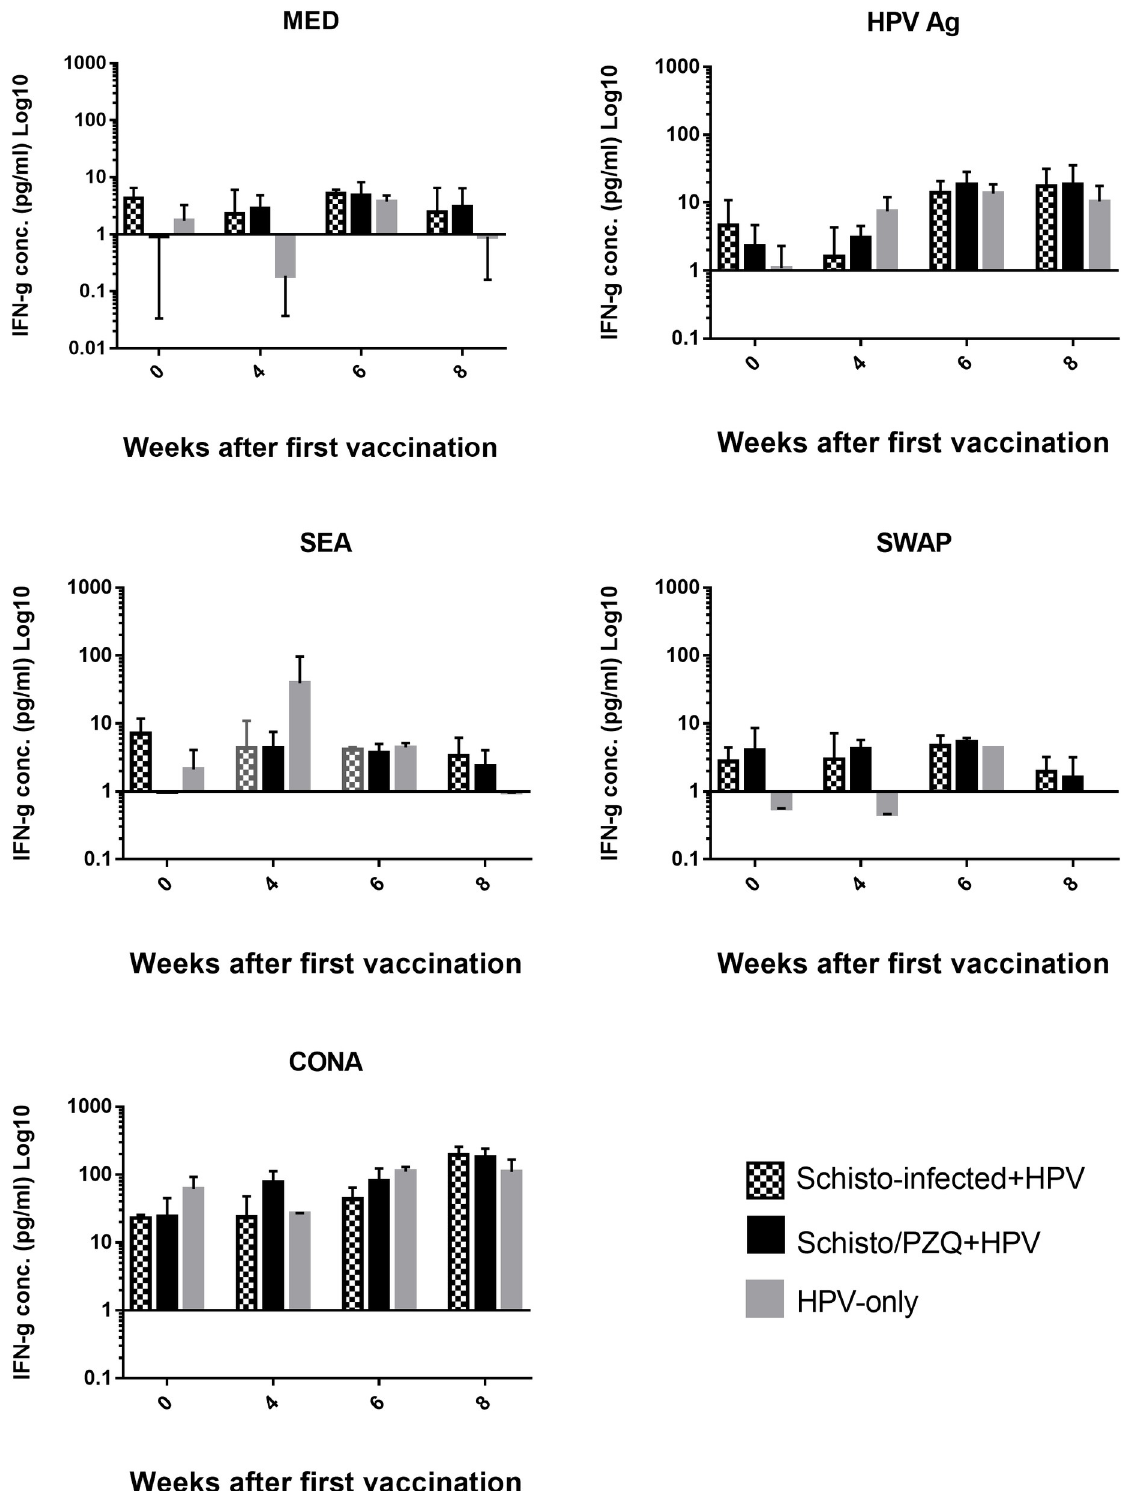
Fig 7. IFN- γ cytokine concentrations. Production of IFN- γ cytokine in supernatants during Specific (HPV, SEA and SWAP) and non- specific stimulation (CONA) and absence of stimulant (MED) in Schisto-infected+HPV, Schisto/PZQ+HPV vaccine and HPV Vaccine only (Control) groups. PBMCs collected from the 3 groups (n = 3) at the 4 time points; Week0 (Pre-vaccination), Week 4 (4 weeks after the 1